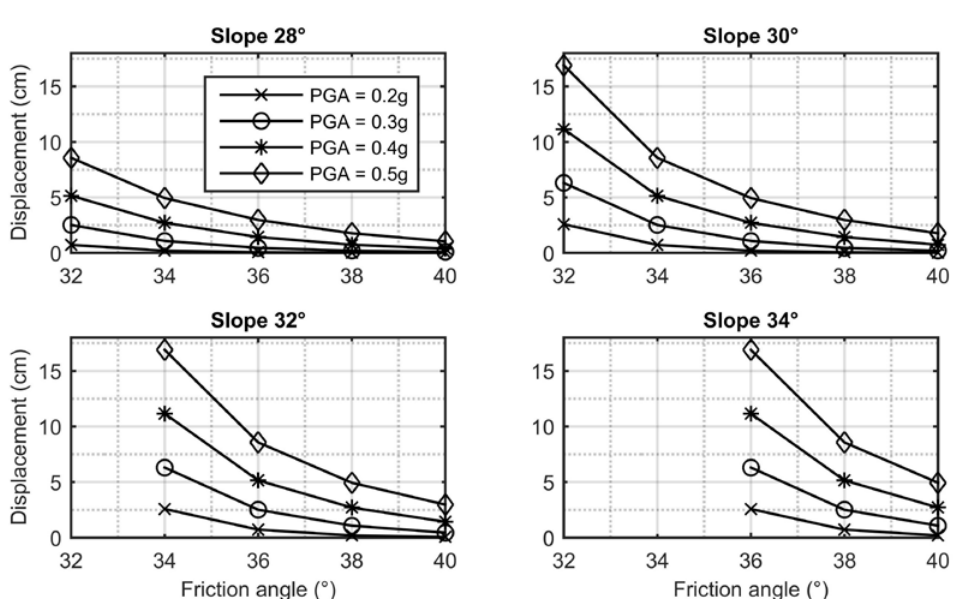
Figure 4: Results of the parametric analysis expressed as the maximum downslope displacements versus slope angle, friction angle and